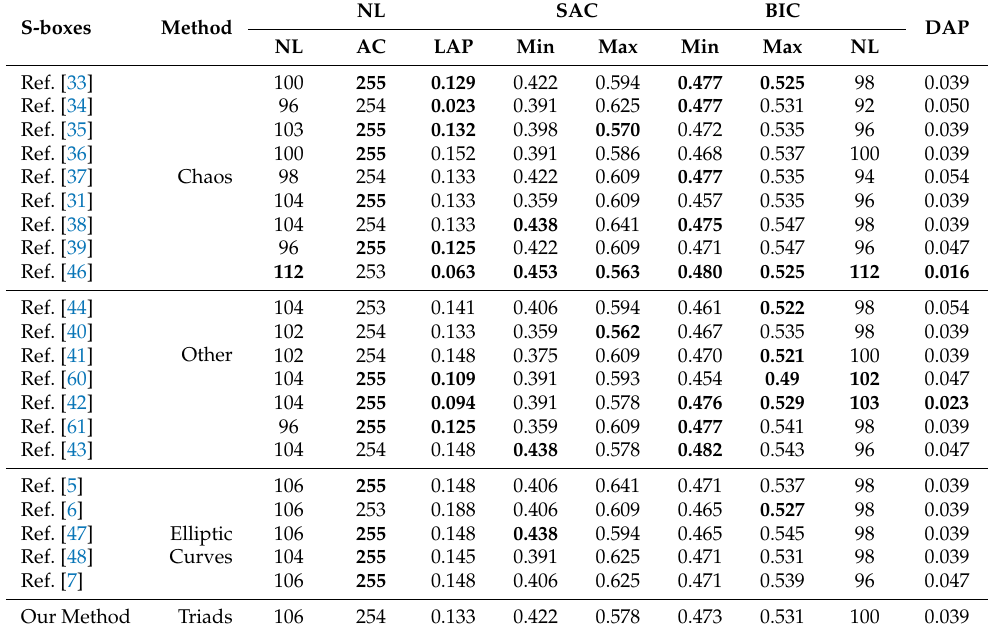
Table 7. Comparison of S-boxes across a range of methods (rows) against our method based on triads. The comparison is made over nine different indicators (columns). For each indicator (column), we present in boldface the methods that outperform our